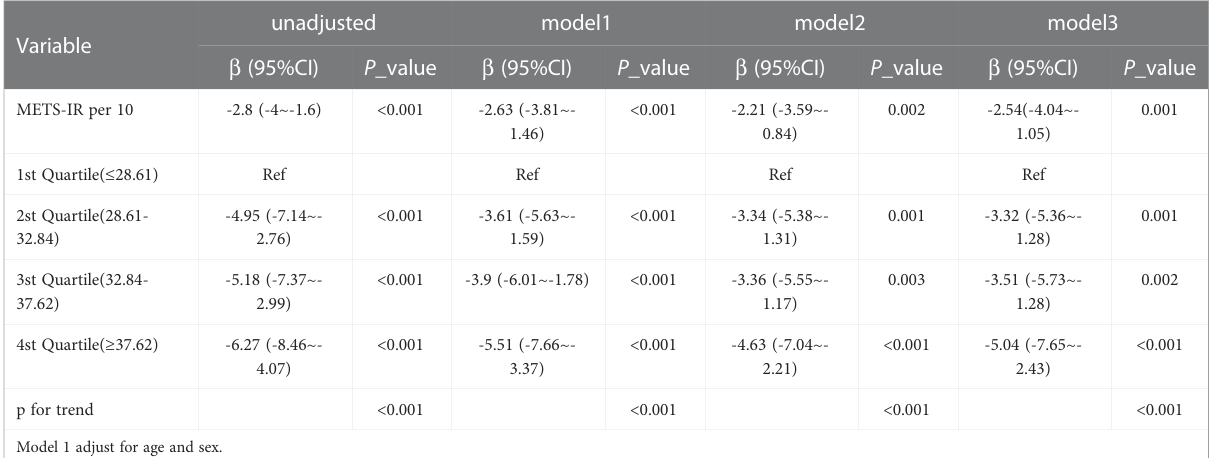
TABLE 3 Multivariable-adjust b and 95%CI of the METS-IR index quartiles associated with eGFR.